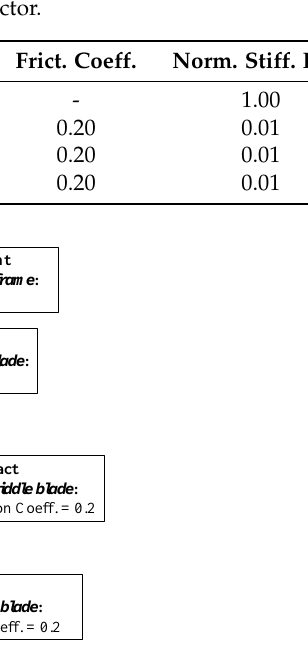
Figure 15. Joint and contact modeling in the 3D FE model. See also Table 6. Bolt modeling : In MyFlex- γ , the elastic elements were joined together with two preloaded M8 bolts. In addition, the middle blade and the spring holder were joined with preloaded M6 screws. The screws were modeled as preloaded spring joints (ANSYS; COMBIN14) and with specific axial stiffness and pretensions that corresponded to M8 (front bolts) and M6 (spring holder bolts). The extremities of the springs were applied, as remote attachments , on the portions of the upper-blade top surface and on the bottom of the lower-blade surface to simulate the washers’